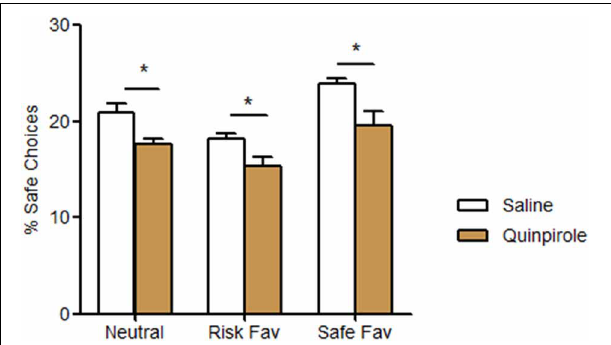
FIGURE 4 | Acute behavioral effects of D2/D3 agonist Quinpirole. Quinpirole treated animals increased the percentage of risk choices in all different probabilities protocols. ∗ p < 0 .